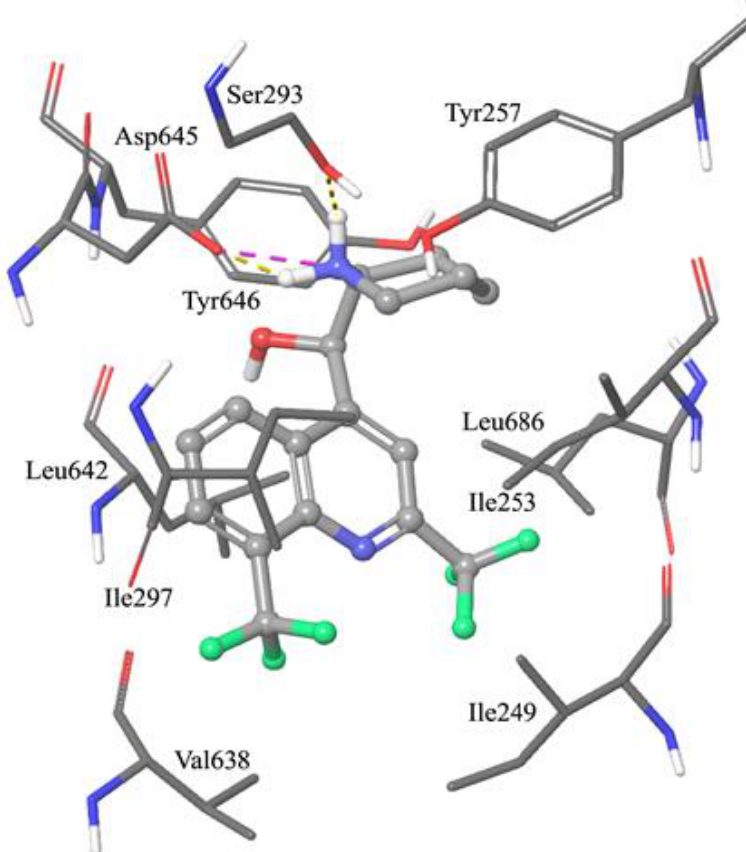
Figure 4. Graphical representation of the interaction pattern of the best-docked pose of mefloquine within the MmpL3 binding site. Extended hydrophobic contacts involve both the trifluoromethyl substituents and the quinoline core. The piperidine basic nitrogen atom makes a hydrogen bond with the Ser293 side chains, and a charge-reinforced hydrogen bond with the carboxyl edge of Asp645. Amino acids are represented by sticks (atom type notation), while mefloquine is represented by a ball and stick (atom type notation). Yellow dashed lines codify for hydrogen bonds, while the magenta dashed line represents a charge-reinforced hydrogen bond.